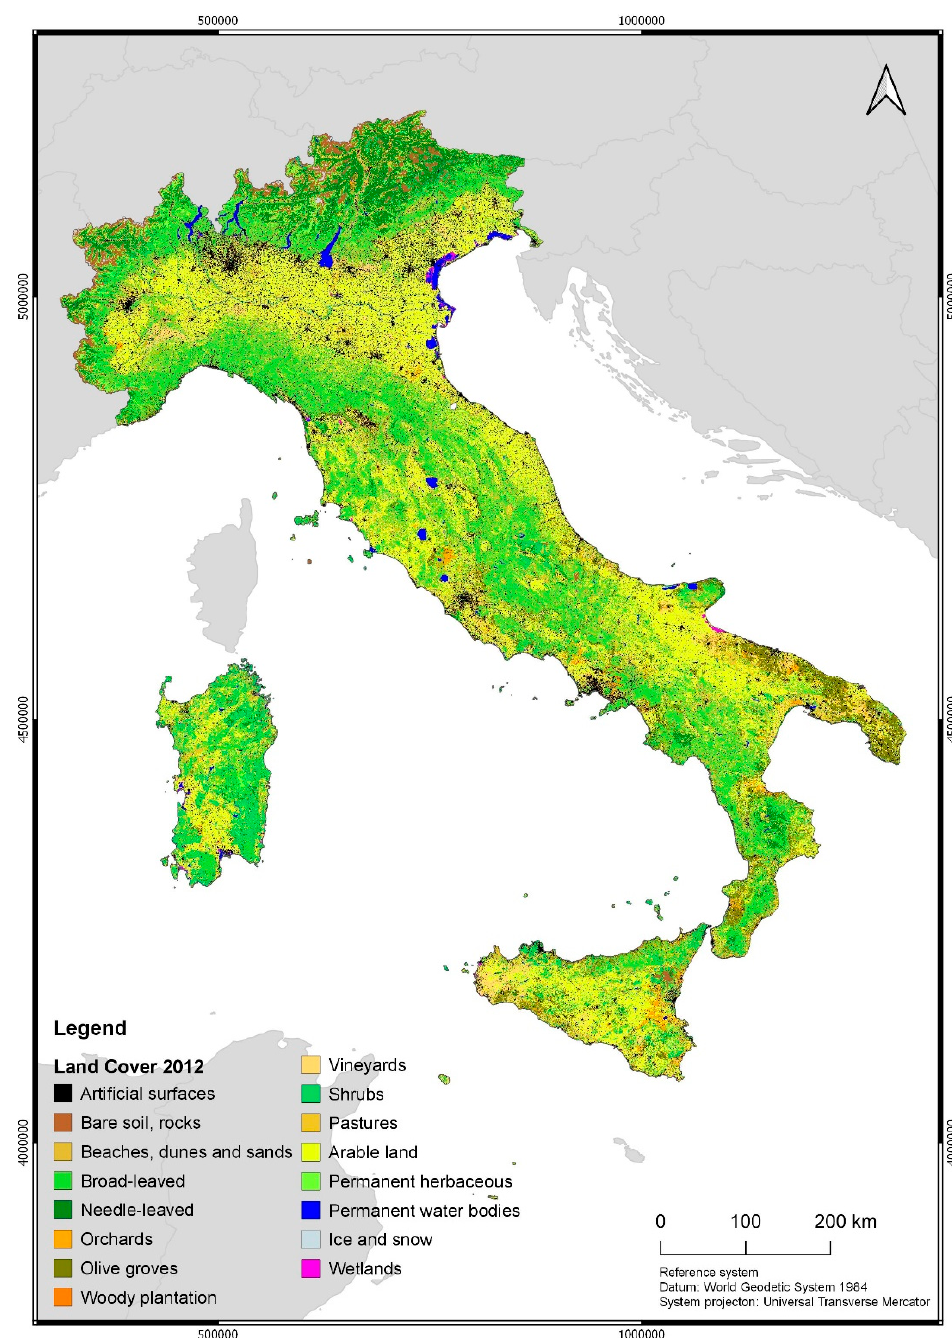
Figure 1. Land cover map for Italy (year 2012).